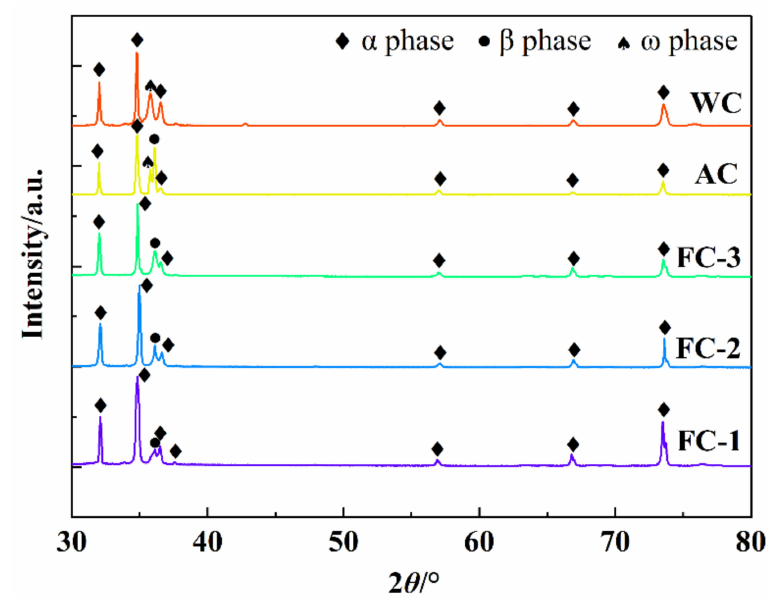
Figure 4. XRD patterns of Zr-4Hf-3Nb (wt%) alloy with various cooling rate.